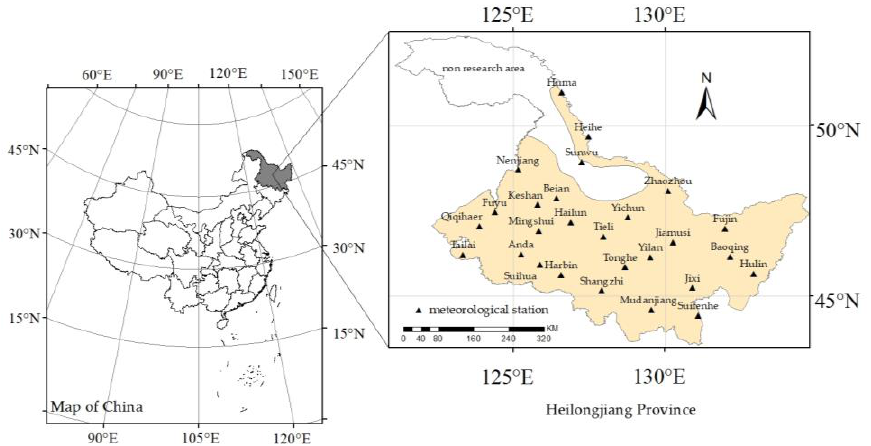
Figure 1. Map of the study area and distribution of meteorological stations in Heilongjiang Province.